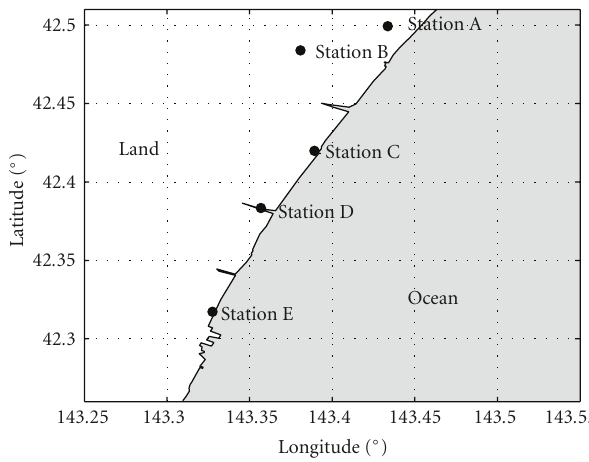
Figure 3: Map of the demonstration area in south eastern Hokkaido, with ground station positions and coastline